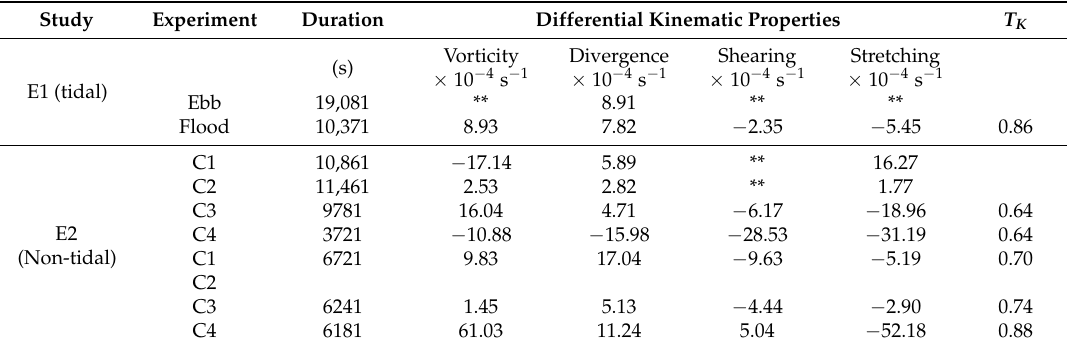
Table 3. Average kinematic differential properties of the Currimundi Lake during E1 and E2.